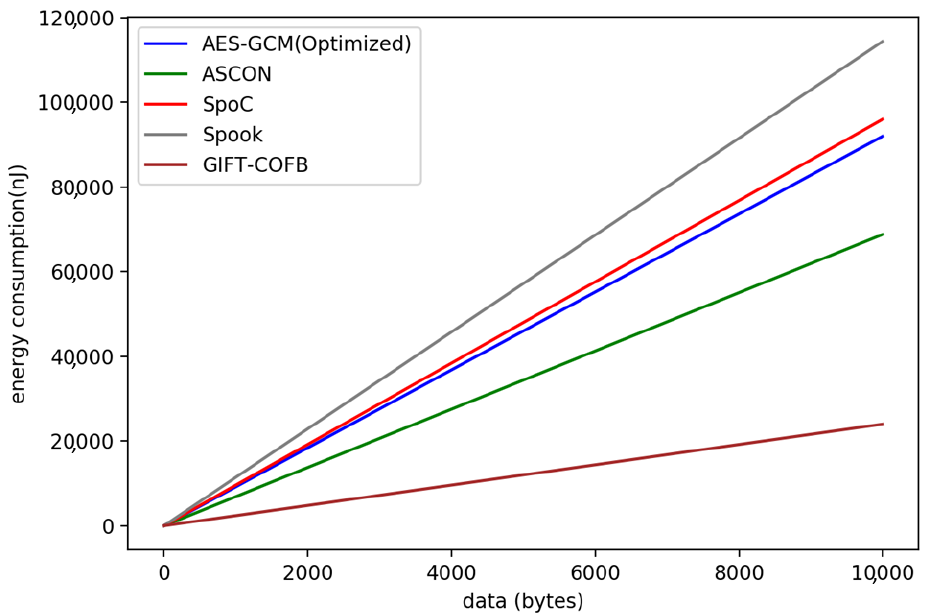
Figure 6. The energy consumption of AEAD